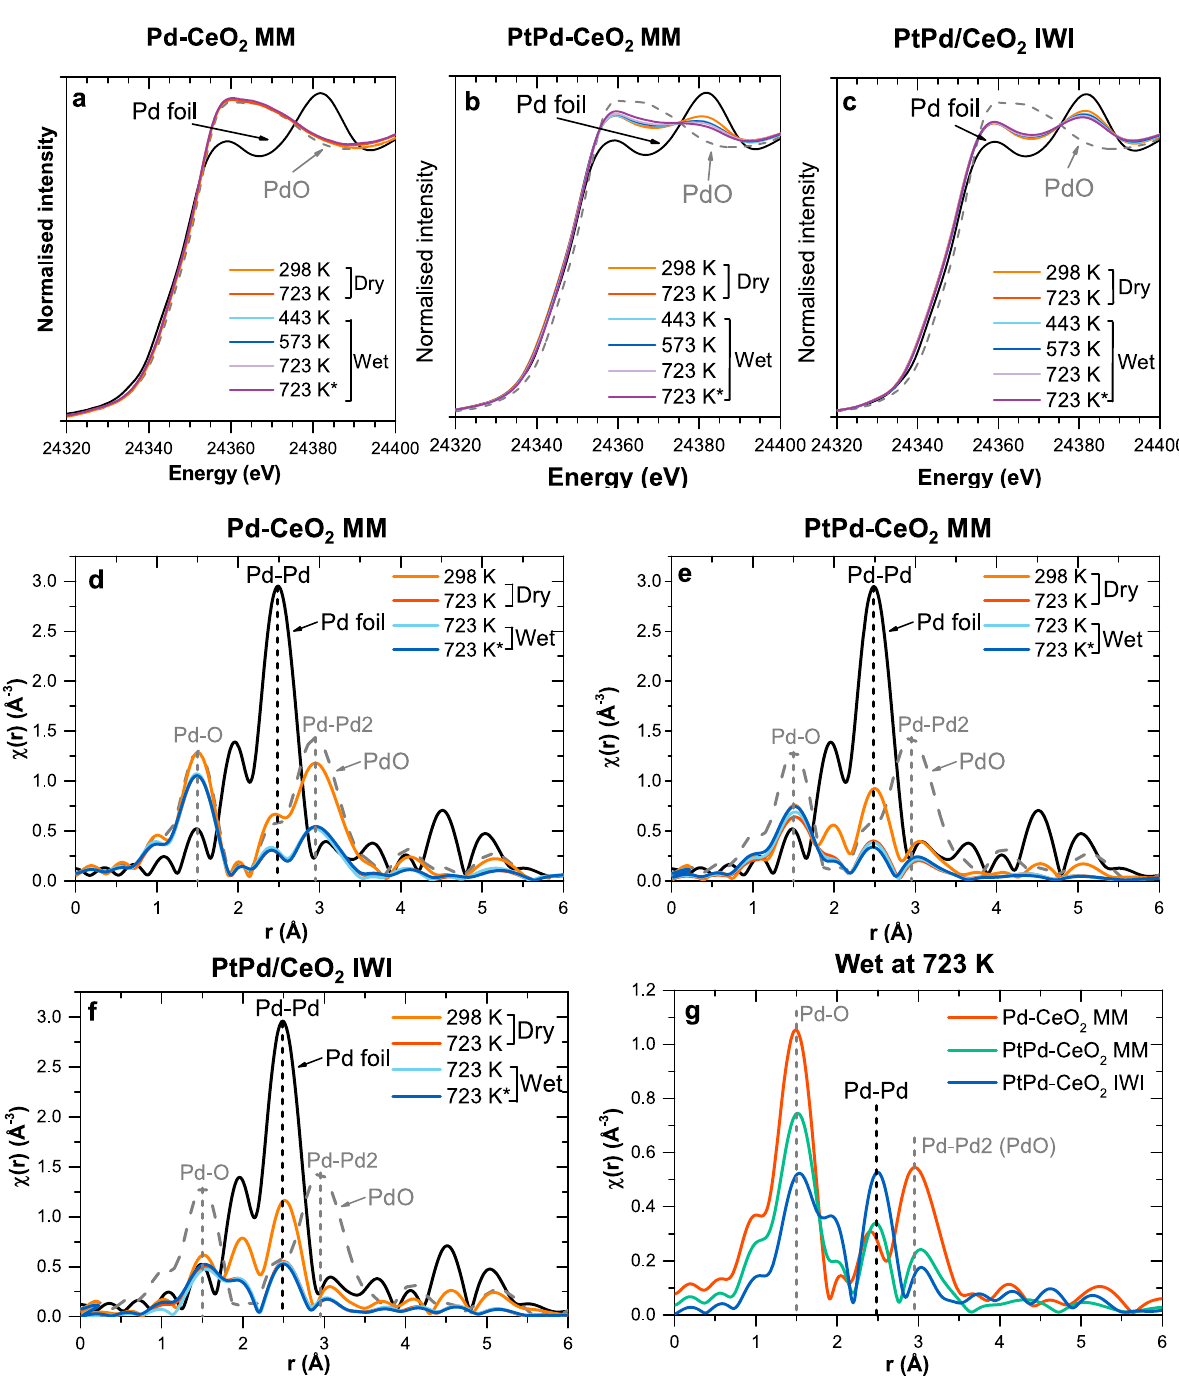
Fig. 4 | In situ Pd K-edge XANES and EXAFS data. XANES spectra of a Pd-CeO 2 MM, b PtPd-CeO 2 MM, and c PdPt/CeO 2 IWI after the TPC1173treatment under dry andwetleanmethanecombustionconditions.Thestateatthebeginningofthewet measurementsat723Kandafter2hareshown,thelattermarkedwith*.Magnitude oftheFToftheEXAFSspectraof d Pd-CeO 2 MM, e PtPd-CeO 2 MM,and f PdPt/CeO 2 IWI after the TPC1173 treatment under dry and wet lean methane combustion